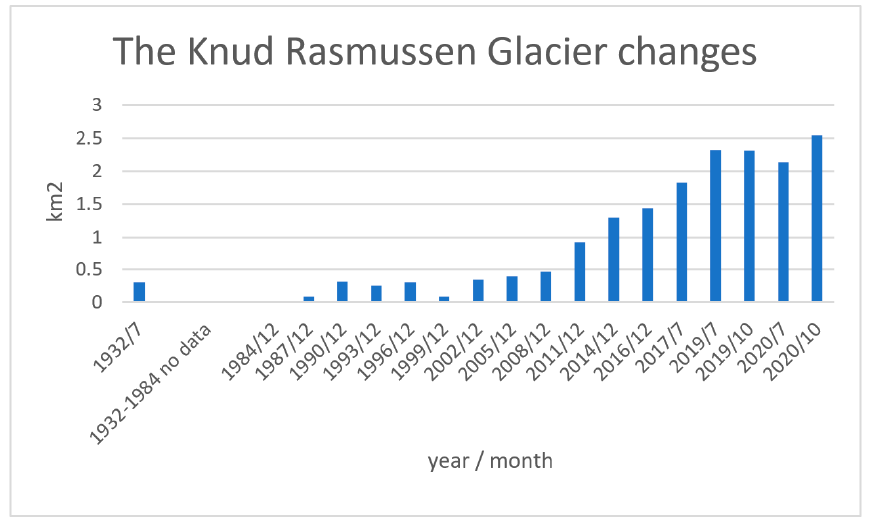
Figure 23. The Knud Rasmussen Glacier area changes between 1932 and 2020; the basic state was the year 1984 (i.e., the state “zero”). Between 1932 and 1984, we do not have data about the glacier sta- tus.